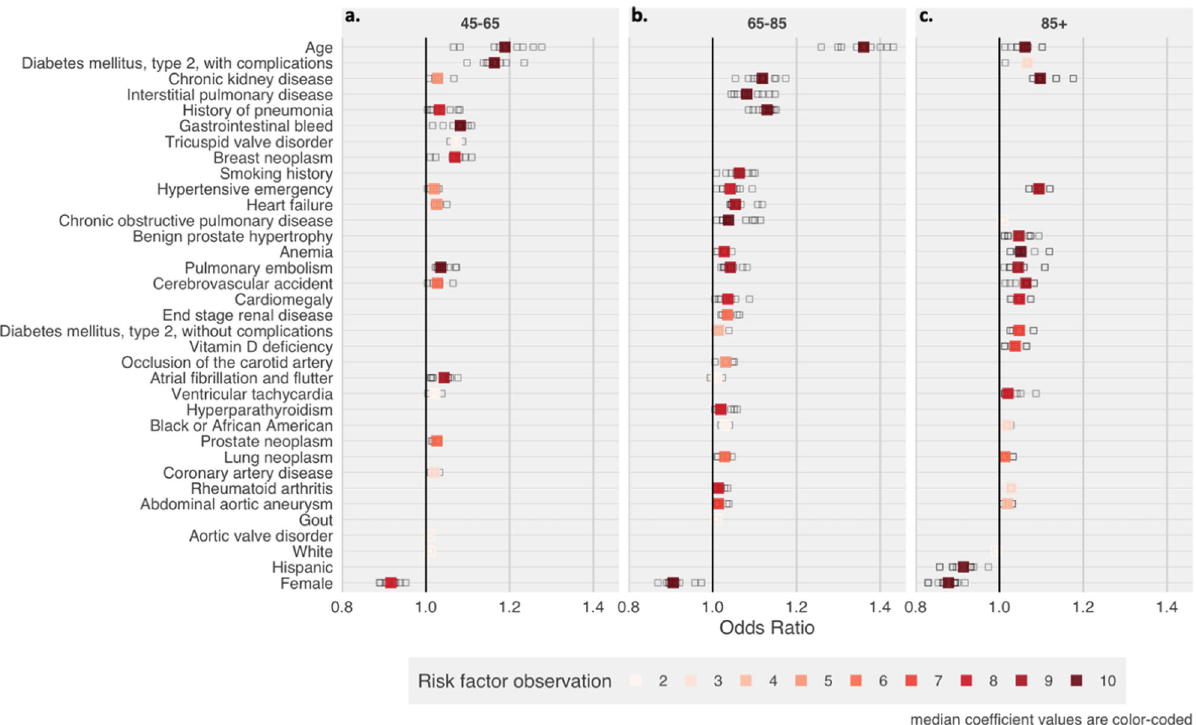
Fig. 4 Odds ratios for the covariates identi fi ed as predictors of mortality in COVID-19 patients by age groups. a Odds ratios for the 45-65 model. b Odds ratios for the 65-85 model. c Odds ratios for the 85 + model. Risk factor observation represents the number of model iterations that identi fi ed a covariate as a predictor of mortality in COVID-19 patients. The total number of model iterations is